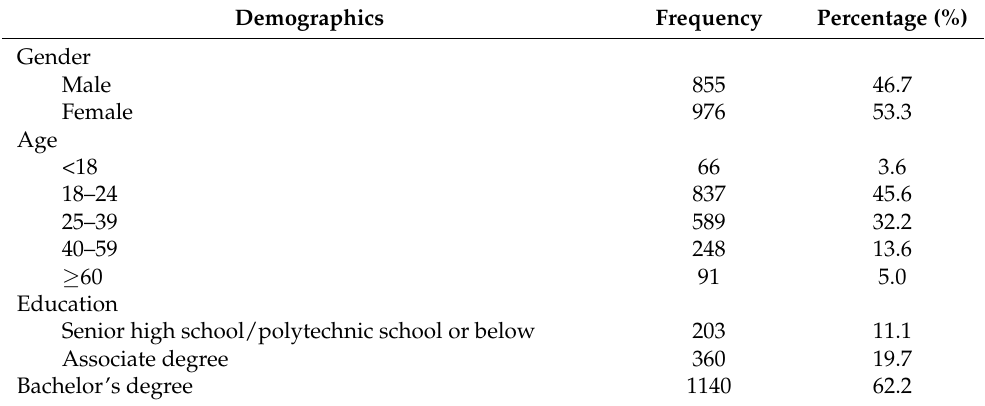
Table 1. Demographic characteristics of